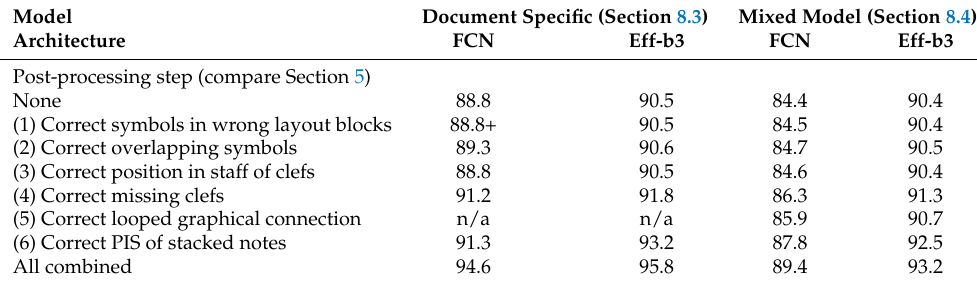
Table 8. Influence of the individual post-processing steps on the mAR in % of the Pa904 dataset. Each post-processing step is evaluated individually. The entry marked with a plus has improved, but the improvement was too small to be shown in the table. Two models are evaluated: The “Document specific” model which adds a document specific fine-tuning to the mixed model and the “Mixed model“, without fine-tuning, which has been trained on different datasets and subsequently evaluated on this dataset.